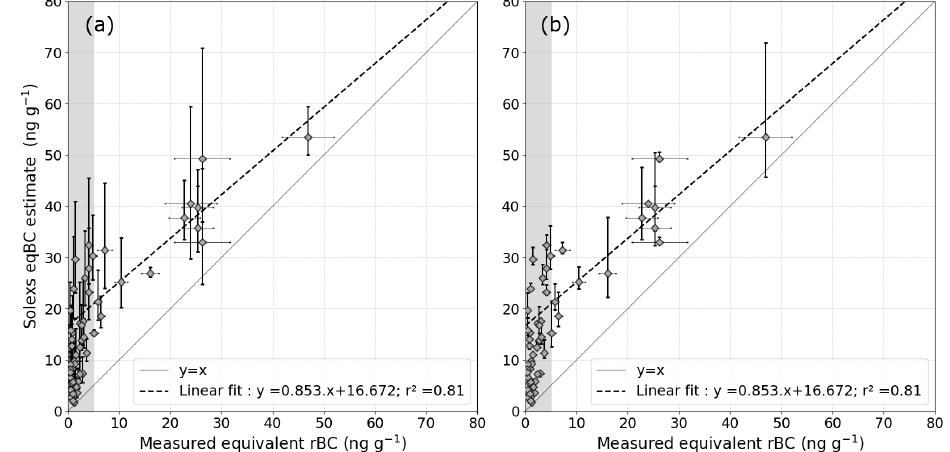
Figure 9. Comparison between measured and estimated eqBC concentrations for all the ZOIs with concomitant LAP measurements. The grey shading corresponds to the zone below the sensitivity limit of our method (i.e. 5ngg − 1 ). (a) Error bars show how uncertainties on BC MAE affect LAP estimates. (b) Error bars show how uncertainties on dust MAE affect LAP estimates.